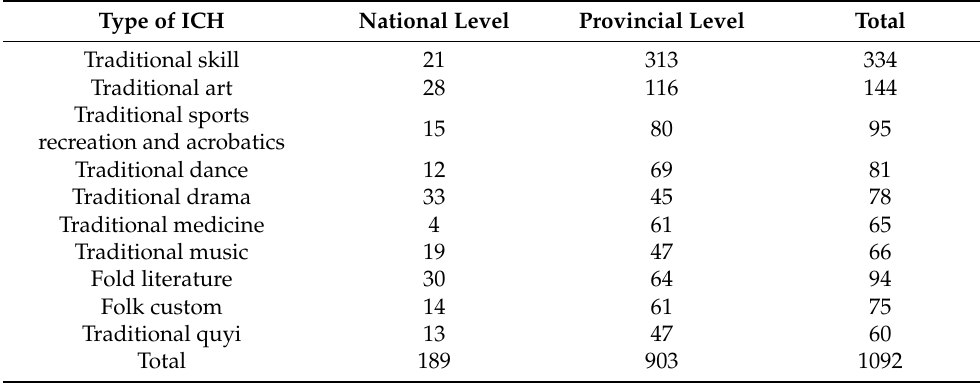
Table 2. The type and number of expressions of ICH. Type of